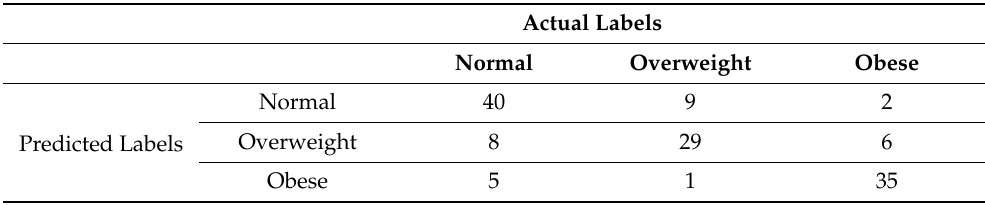
Table 8. Confusion matrix for random forest implementation for determining obesity category based on early visits (balanced data).